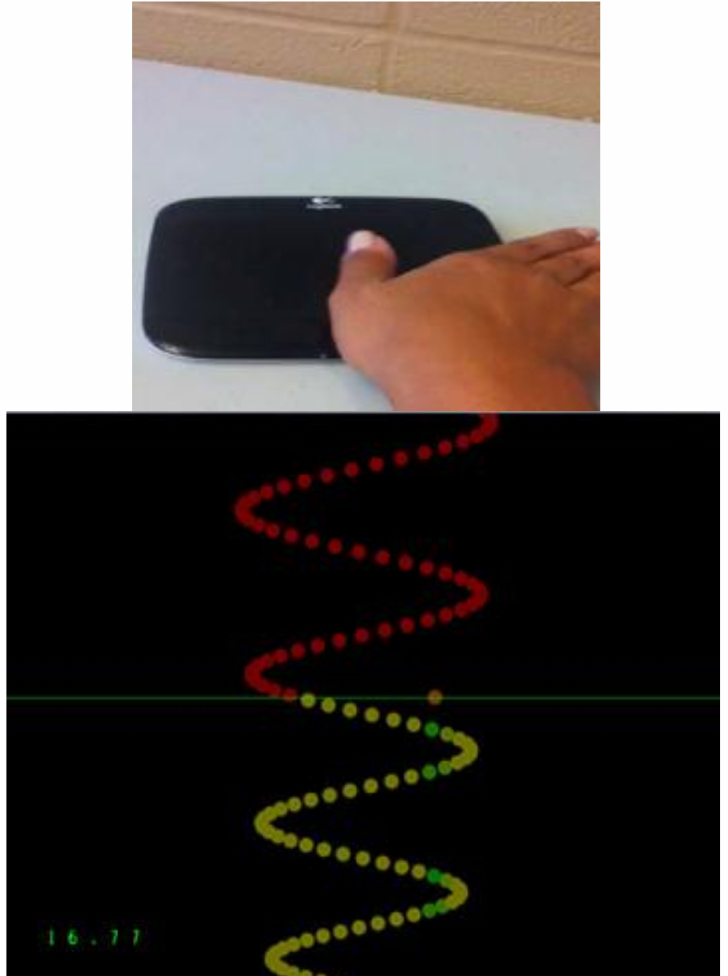
Figure 2. Photographs of the computer monitor showing one version of the motor tracing task performed by each participant task and a participant’s hand on the wireless touchpad that was used to perform the tracing task. The traces consist of a series of dots which the participant tracked when the trace passed a horizontal line. The orange dot shows the location of the participant’s cursor along the horizontal line. Motor performance error was calculated as the average distance that the cursor was from the “perfect”